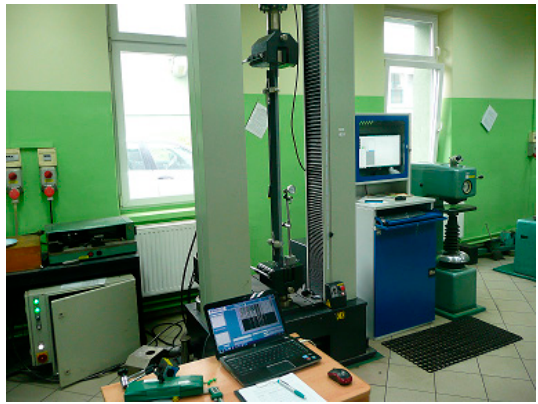
Figure 2. Laboratory stand intended for the calibration of the strain-state measuring system.